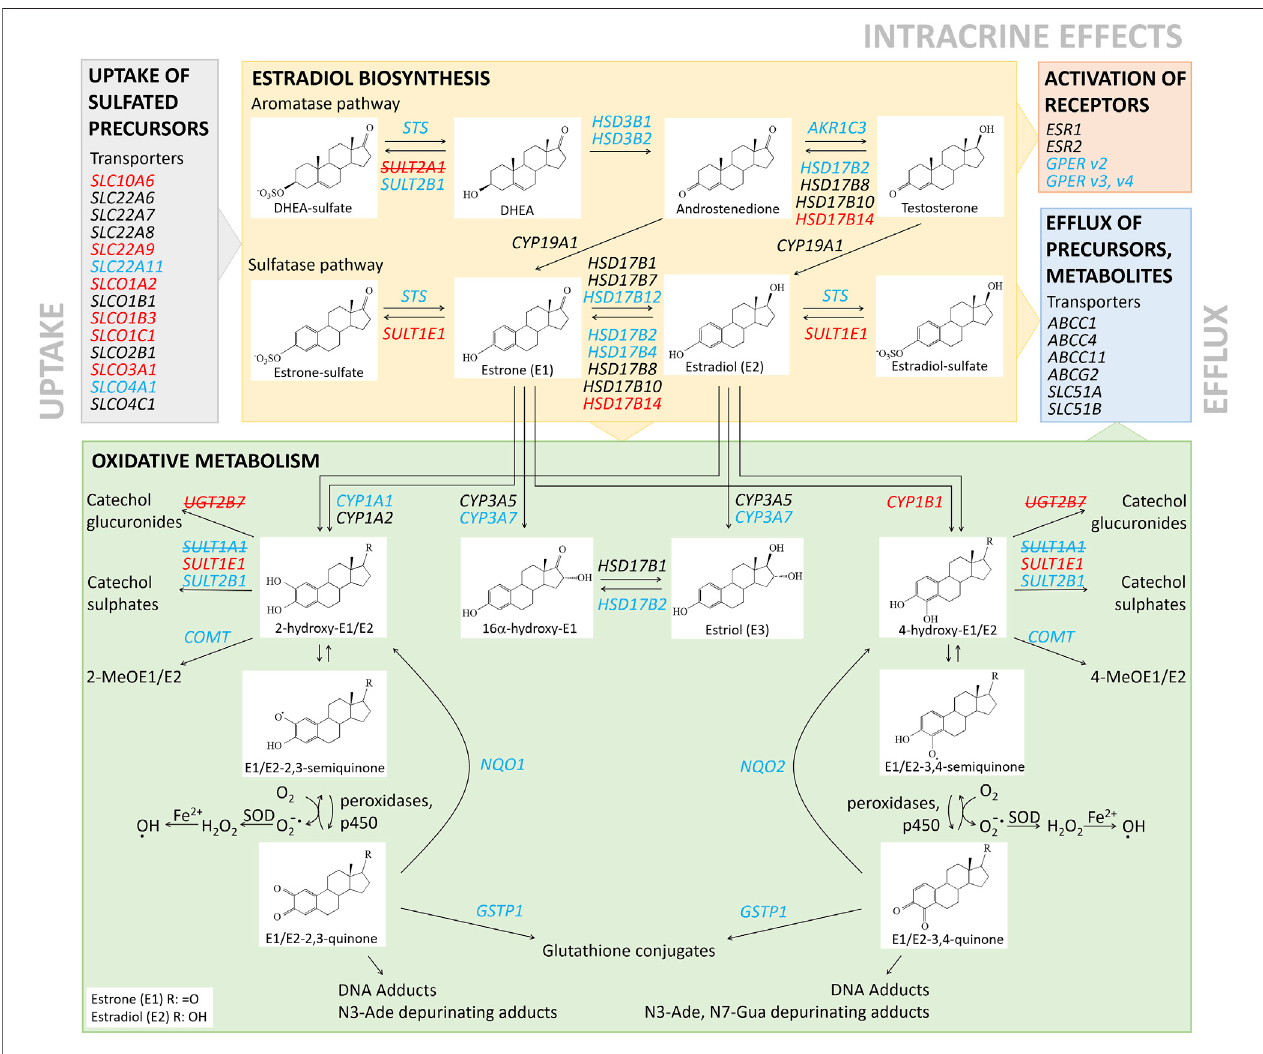
FIGURE 3 | Schematic representation of local estradiol biosynthesis and metabolism in RL95-2 and KLE cells. Genes with higher and lower relative expression for KLE vs RL95-2cellsareindicatedinredandblue,respectively.GenesinredandbluewithstrikethroughwerenotexpressedineitherinRL95-2orKLEcells,respectively.